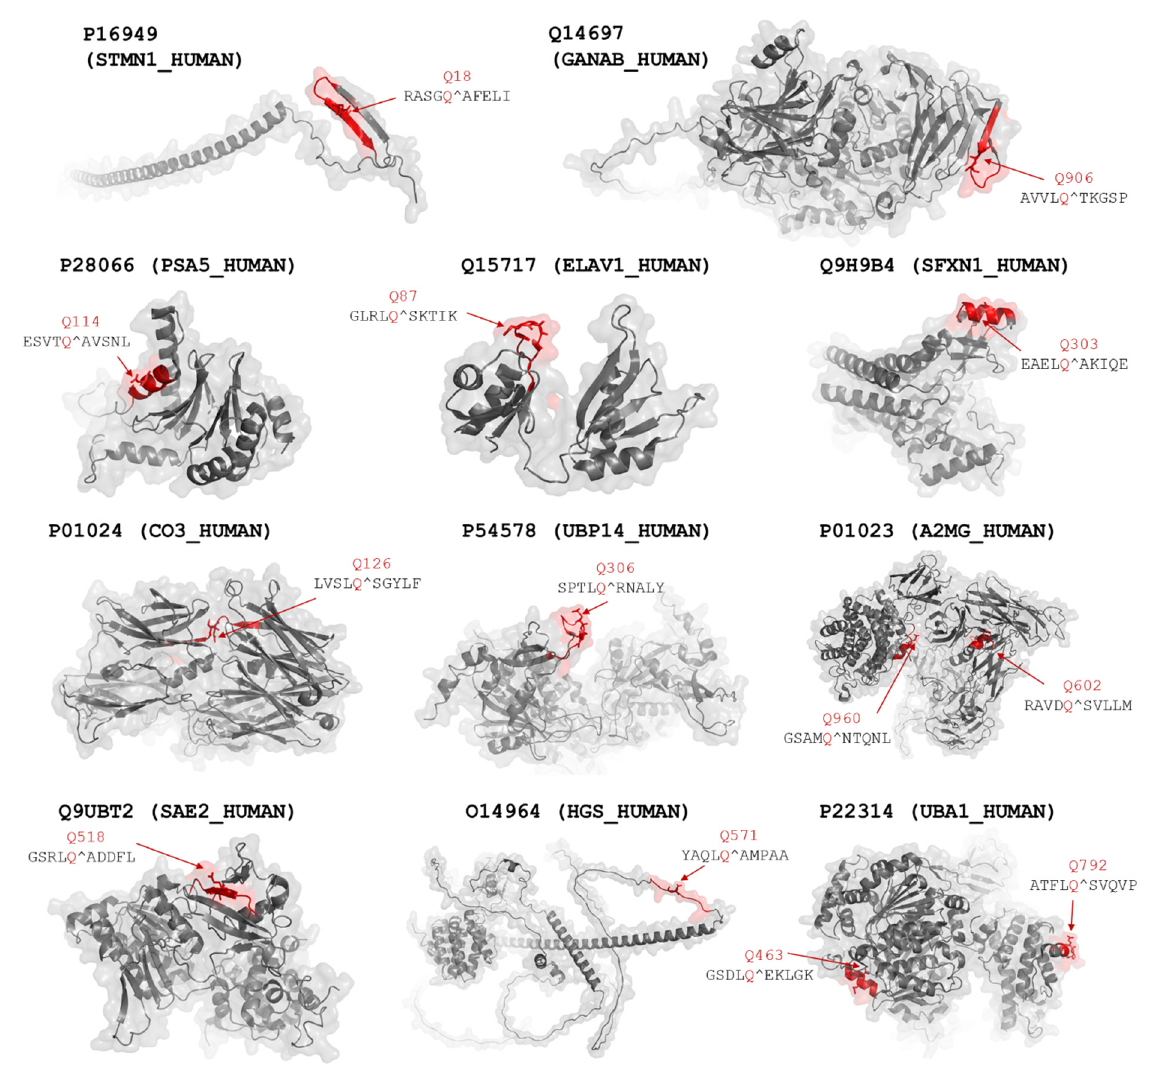
Figure 5. Structures of potential proteolytic targets of SARS-CoV-2 Mpro. Cleavage sites that were identified using NetCorona 1.0 web server are highlighted in red. P1 Gln residues of the cleavage sites are represented by sticks and shown by the arrows. Predicted cleavage probabilities are shown in Table 1.